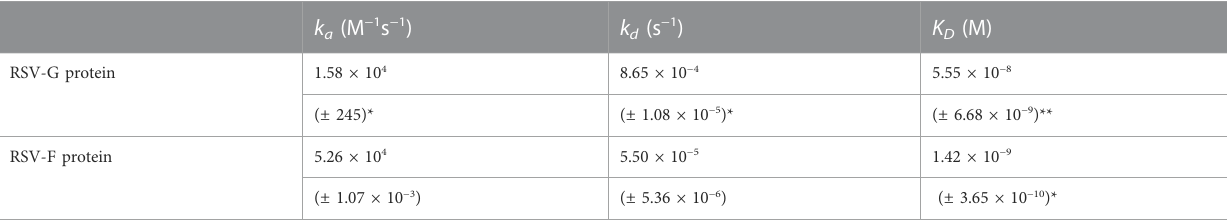
TABLE 1 Summary of kinetic data of RSV-G protein and RSV-F protein binding with heparin.